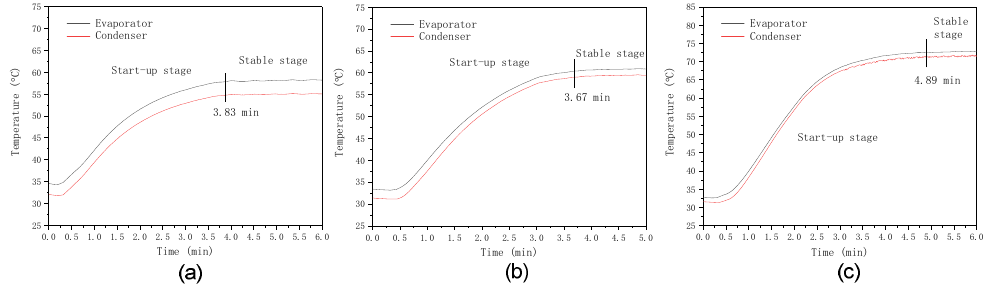
Figure 8. Start-up characteristics of heat pipes with different kinds of vapor chambers ( a ) cylinder, ( b ) blunt cone, and ( c ) sharp cone.